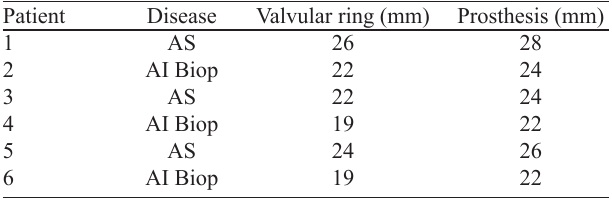
Table 3. Correlation between diameters of valvular ring and implanted prosthesis.